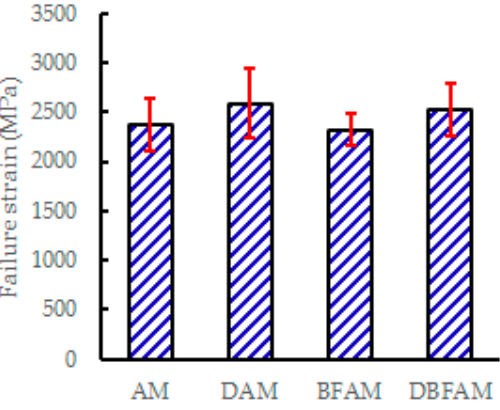
Figure 11. IDT failure strain of asphalt mixtures.